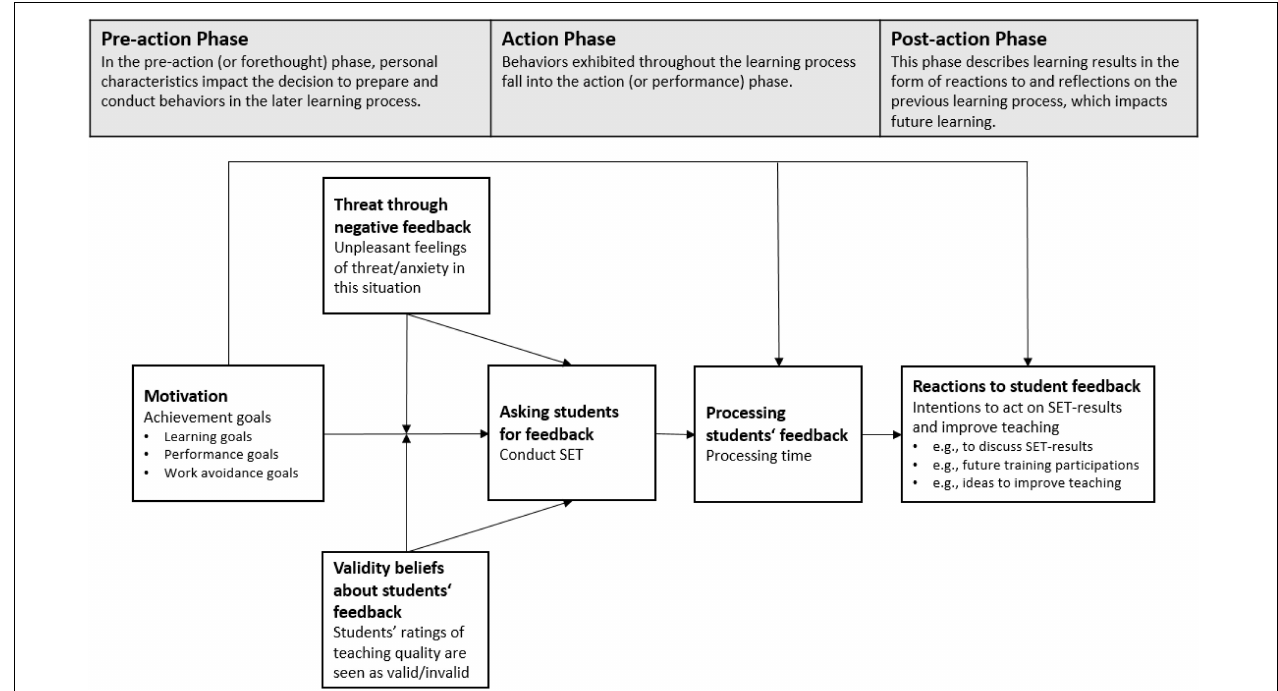
FIGURE 1 | Proposed model for the voluntary usage of SETs as a learning